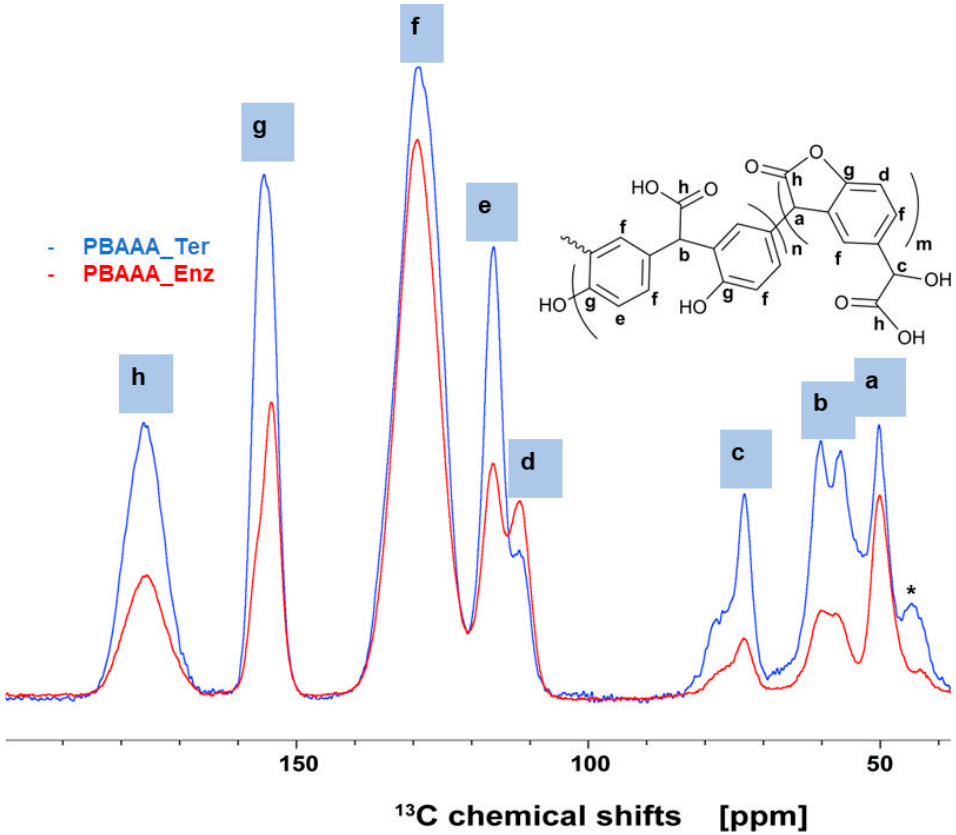
Figure 1. 13 C ss-NMR spectra of the PBAAA polymers: PBAAA_Ter under thermal conditions (solid blue line) and PBAAA_Enz under enzymatic conditions (solid red line). The asterisk indicates a sideband.